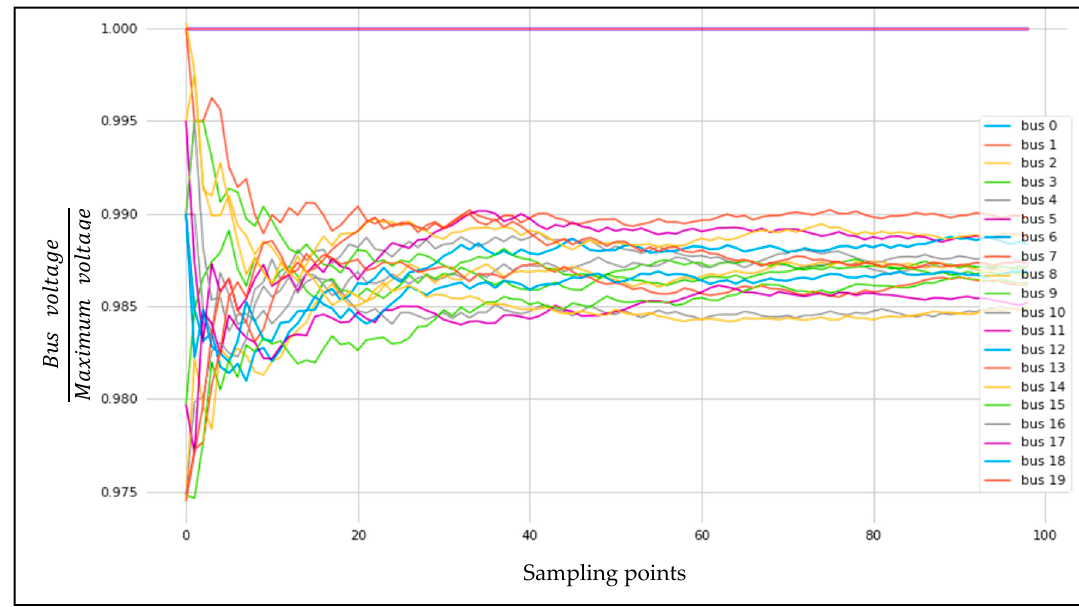
Figure 8. NASA N3-X RTO Monte Carlo branch loading average.